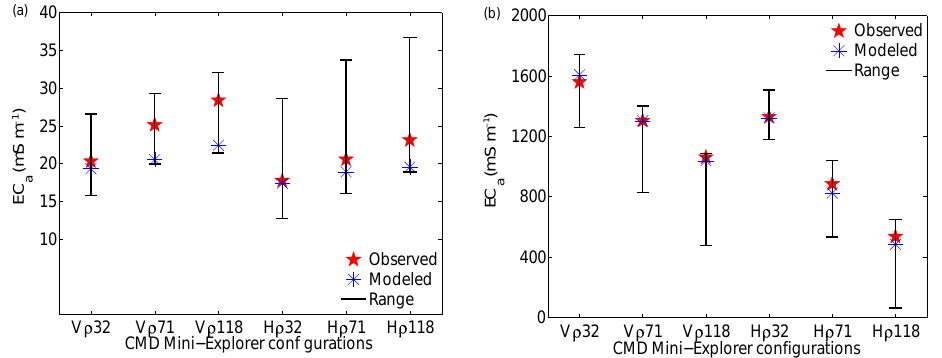
Figure 2. Observed electrical conductivity obtained from the forward response of the six different configuration of CMD Mini-Explorer (red star), estimated (modeled) earth electrical conductivity (blue asterisk) and the range of EC a simulated by MCMC for (a) non-saline and (b) saline soil scenarios.